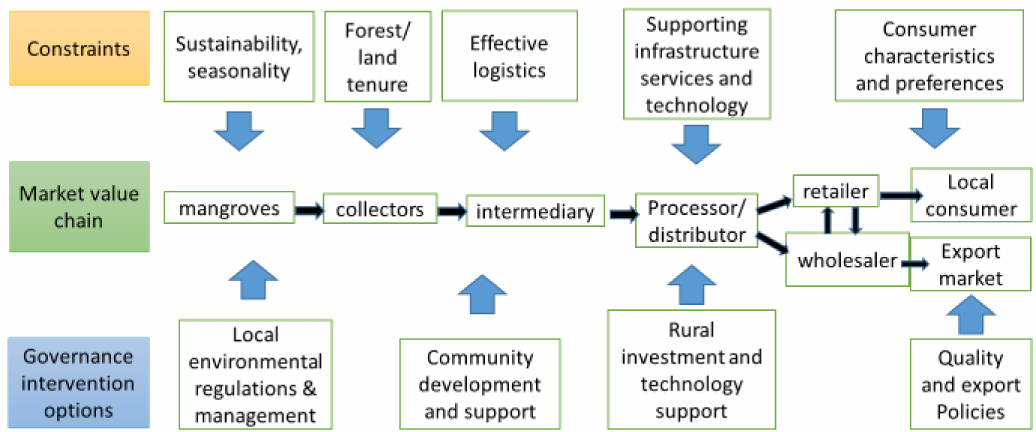
Figure 5. Mangrove value chain with the constraints and enablers that operate at di ff erent stages along the supply chain, modified from Pandey et al. [57] and Berkum et al.